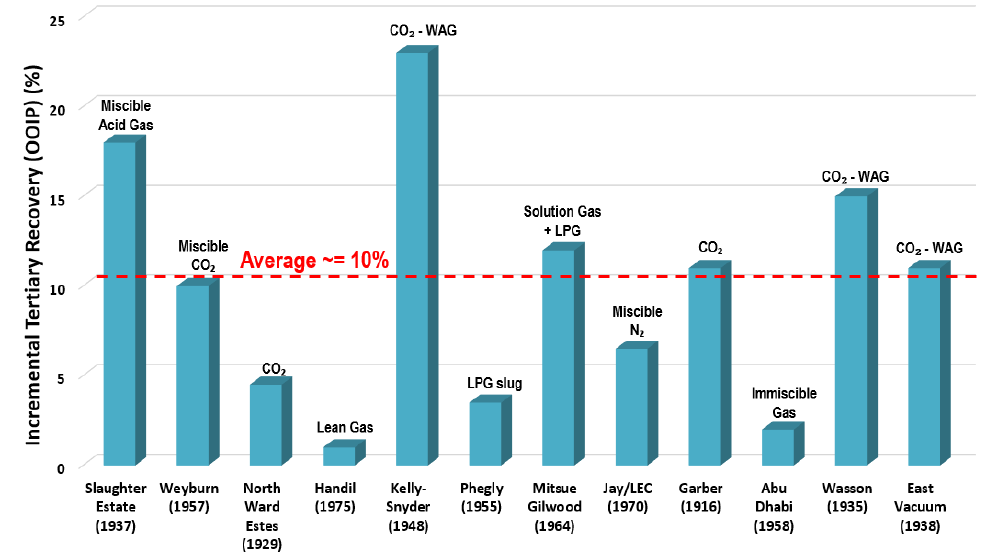
Figure 1. Incremental tertiary recoveries by gas-injection in selection successful EOR projects; the dates in the x-axis indicate the discovery years of the